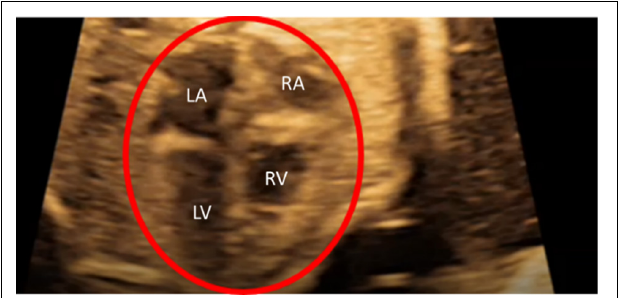
FIGURE 1 | Sample medical image of a fetal heart which is clearly indicating the four heart chambers. This example is for a 26-week fetal heart. LA is left atria, LV is left ventricle, RA is right atria, and RV is right